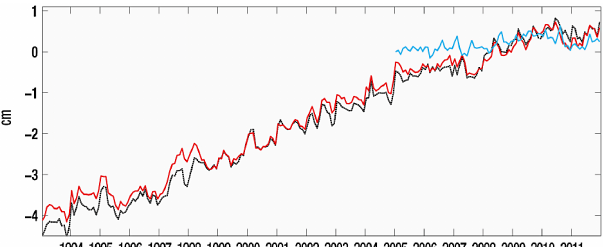
Figure 5. Global mean total (black dashed) and steric (blue, Fig. 3) sea level, together with global total sea level where data in the Trop- ical Asian Archipelago (TAA) have been ignored (red). The area for the TAA test (see text for more details) is added in Fig. 4b (green